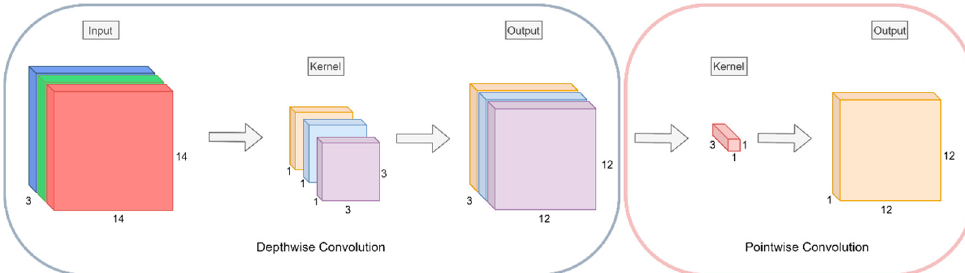
Figure 3. Example of operation of Depthwise Separable Convolutions (DWSC) performed on an image as input of dimensions 14 × 14 × 3. First, a depthwise convolution is performed with three kernels of dimension 3 × 3 × 1, followed by a pointwise convolution with one kernel of 1 × 1 × 3.